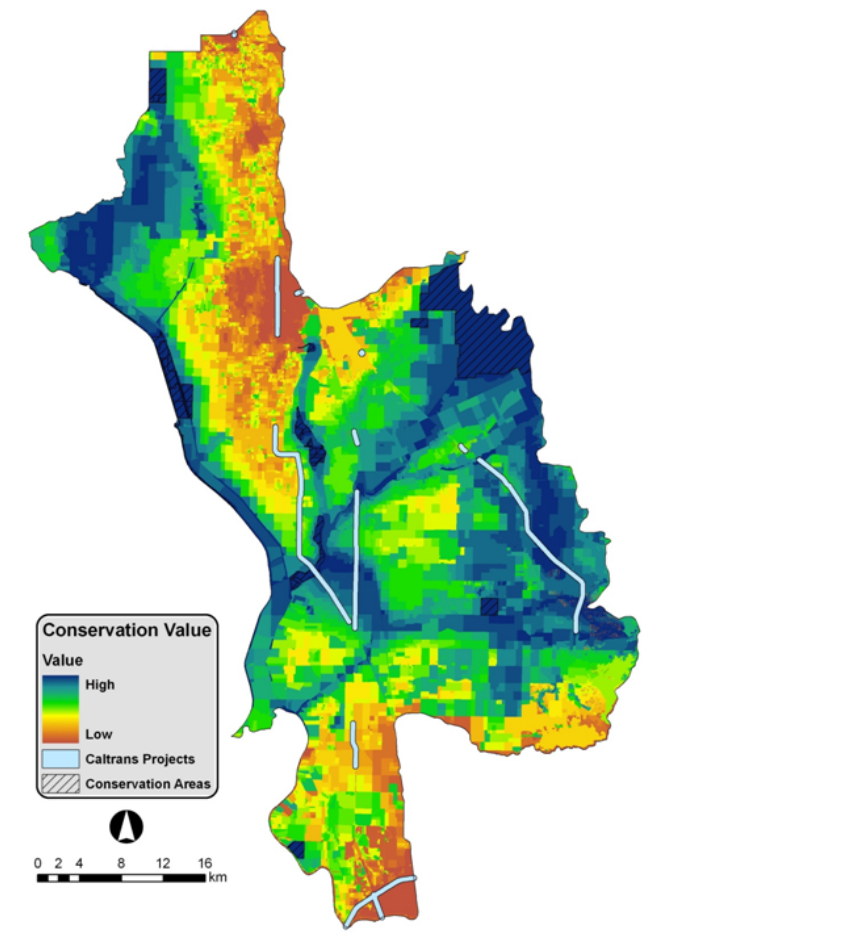
Fig. 5. Regional conservation greenprint based on combined habitat and “core” and connectivity values. Each parcel was assigned a score equal to the maximum of either the “core” or connectivity